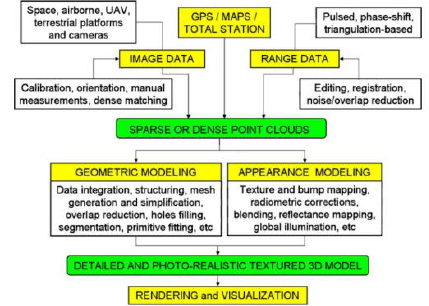
Figure 2 . The multi-sensor and multi-resolution 3D modeling pipeline based on the integration of different techniques for the generation of point clouds and textured